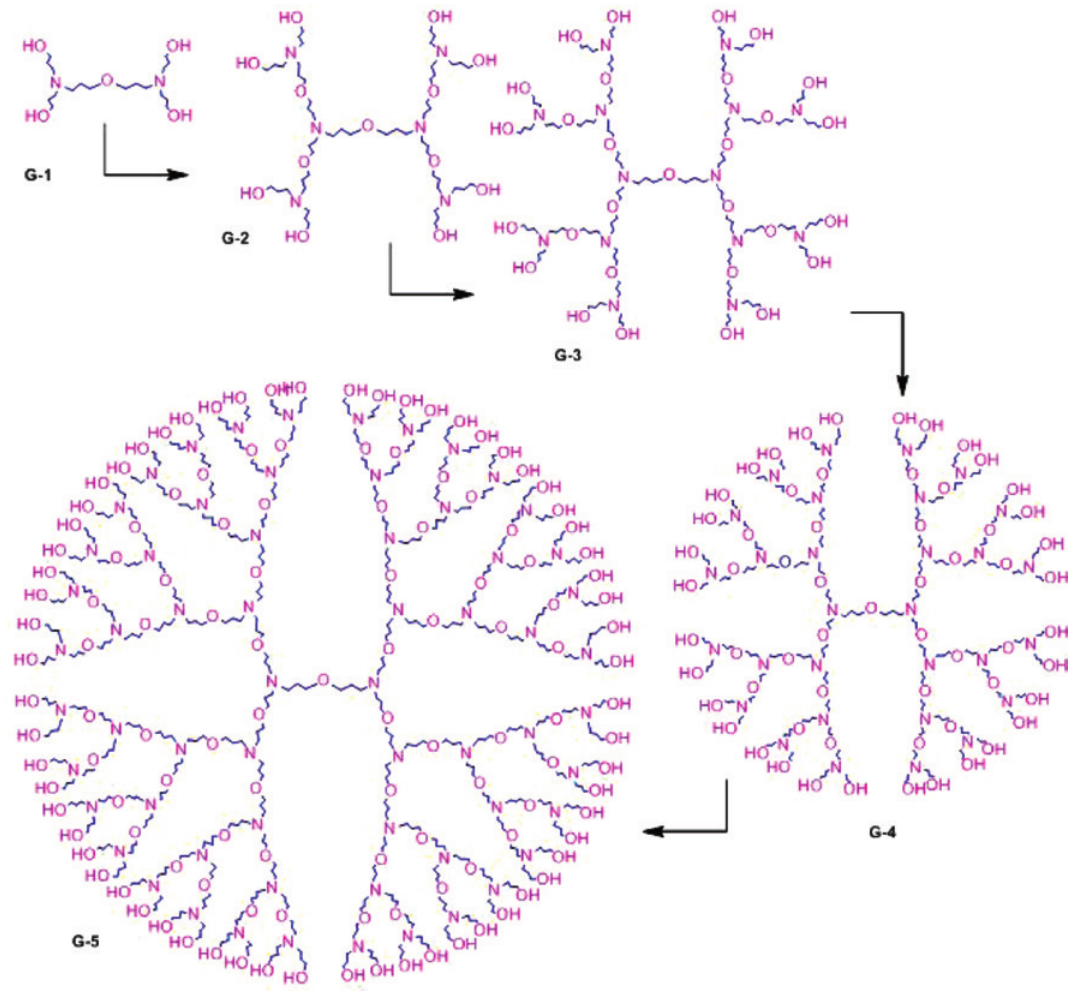
Figure 1: The molecular structure of PETIM dendrimer with nth